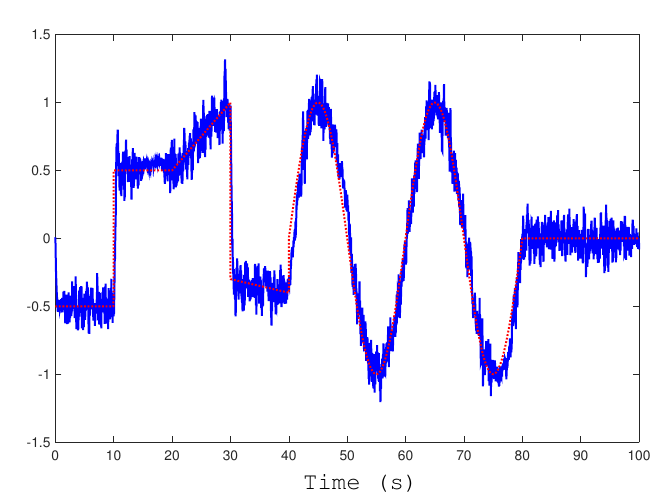
Figure 5. Numerical results: u i ( t ) .